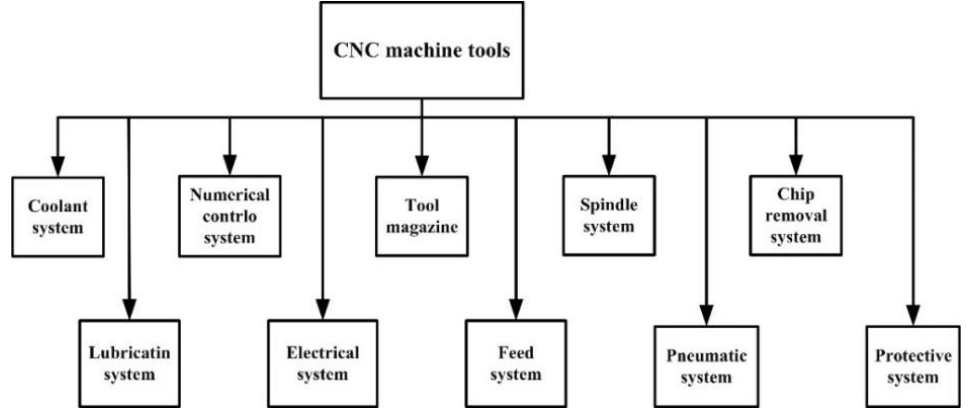
Figure 1. Subsystems division diagram of CNC machine